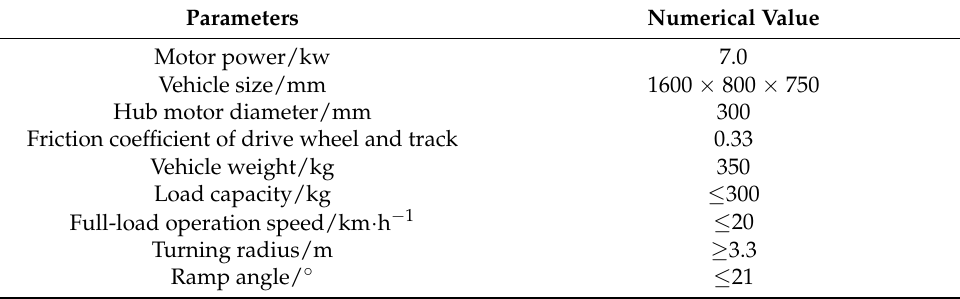
Table 3. Monorail car performance parameters.